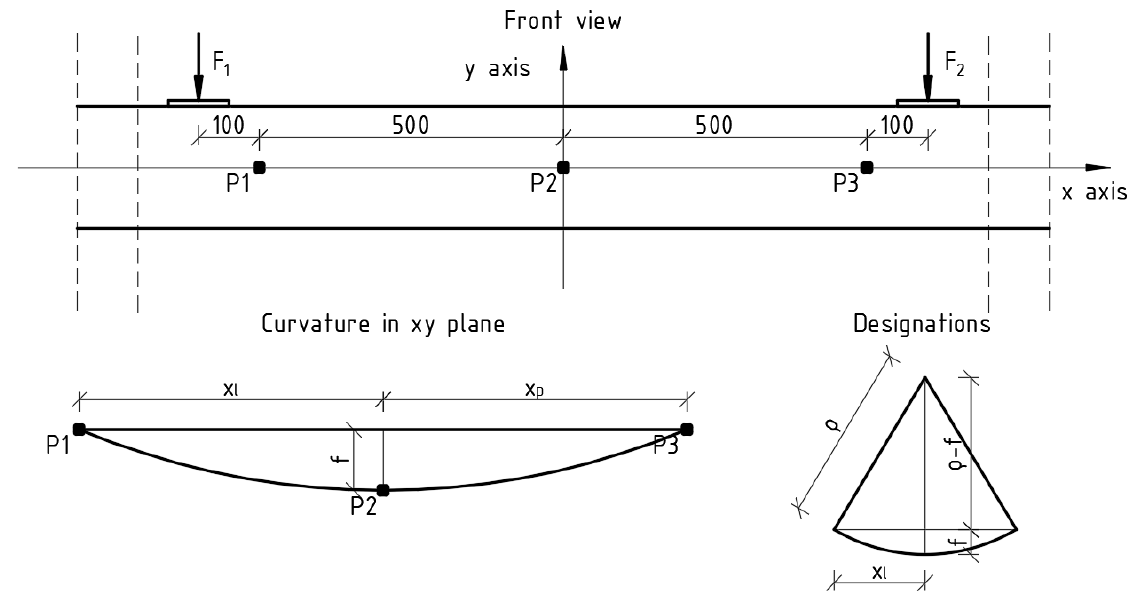
Figure 4. Curvature of bent beam — designations.